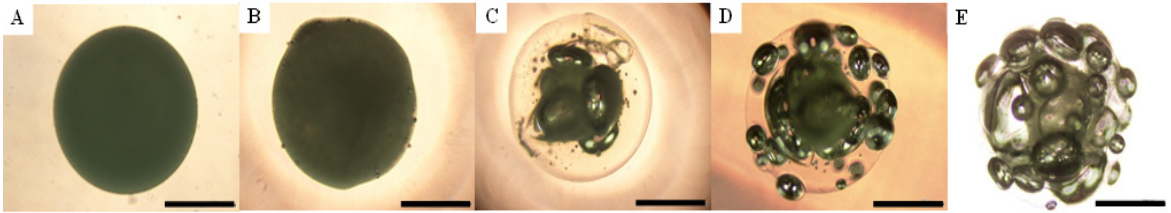
Figure 5. Photo images of a single alginate microparticle prepared by a fixed 5% NaHCO O concentrations: ( A ) 0%, ( B ) 9.12%, ( C ) 18.25%, ( D ) 27.37%, ( E ) 36.5%. and different H 2 2 All scale bars are 1